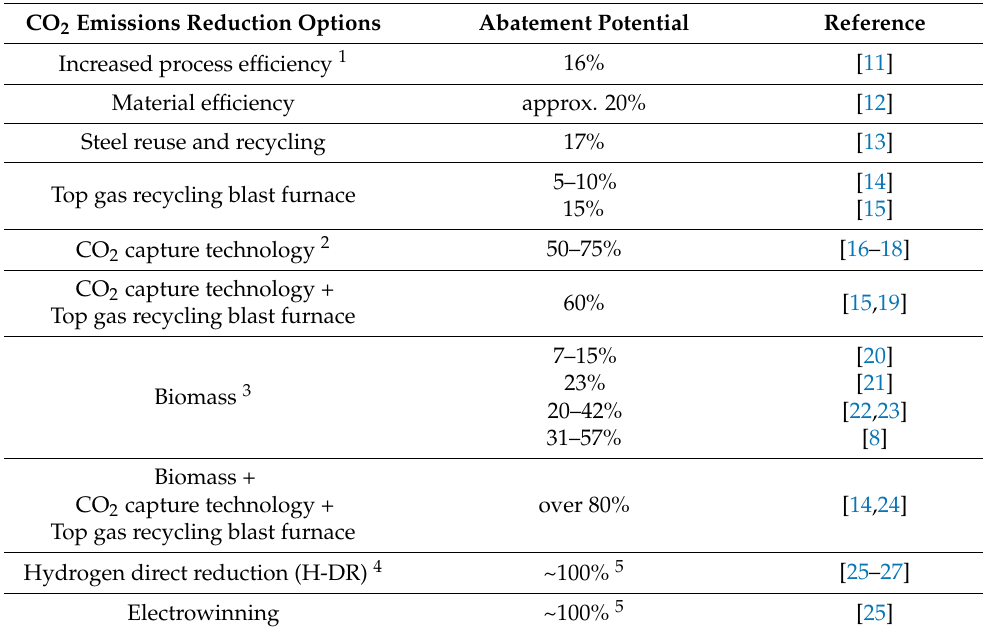
Table 1. The main CO 2 emission reduction options in the steel industry together with their abatement potential as obtained from the